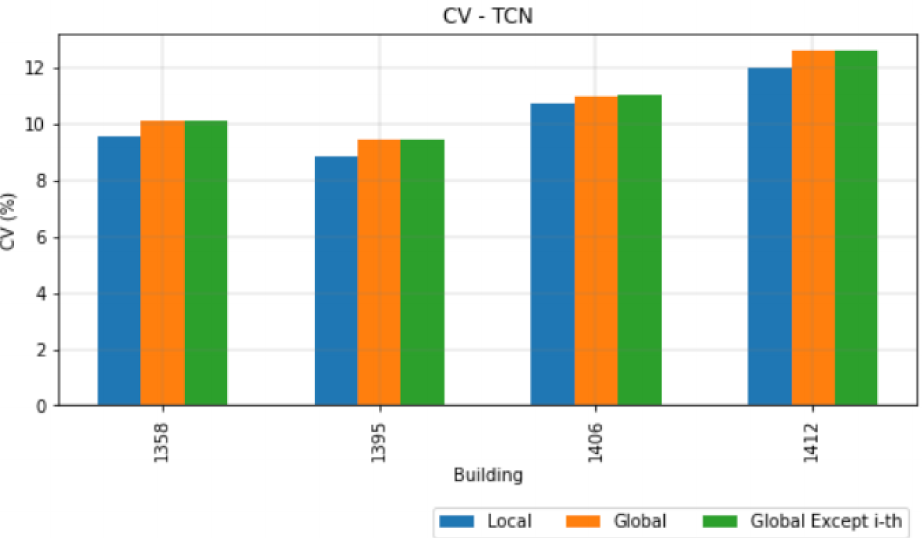
Figure 20. Comparison between the CV on test set obtained using TCN method with different modalities: local, global and global trained using all the available data except the energy consumption related to the selected building.